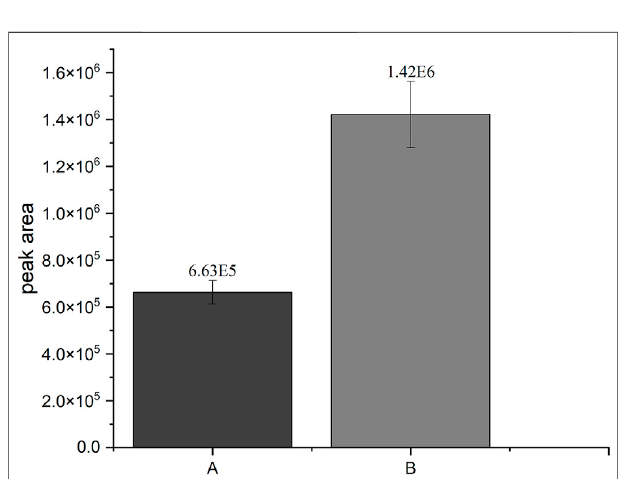
FIGURE 2 | Comparison of the SULT1A3-dependend production of 4HPSU from 4HP under different conditions. A: Peak area of 4HPSU produced with 100 µM PAPS after 3 h incubation; B: Peak area of 4HPSU producedunderoptimizedconditions(11 mMATP,20 mMMgCl 2 ,2.5× 10 8 cells per sample, and after 5 h incubation time). Each experiment was done in triplicates. Error bars show the standard